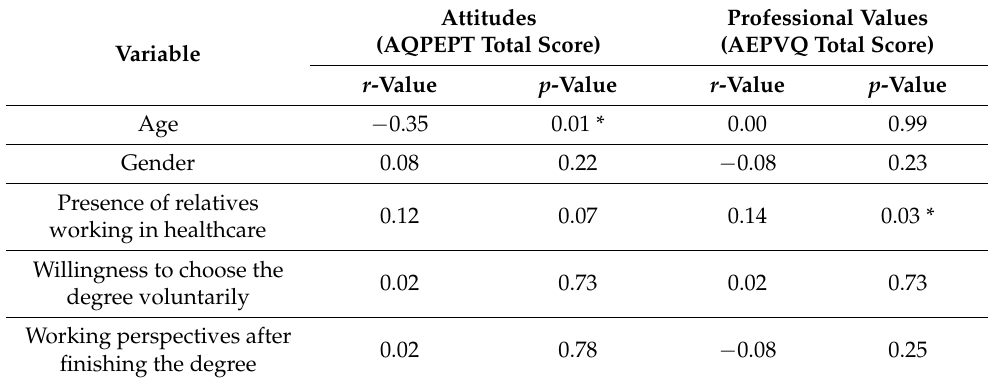
Table 3. Correlation between attitudes and professional values and sociodemographic variables.